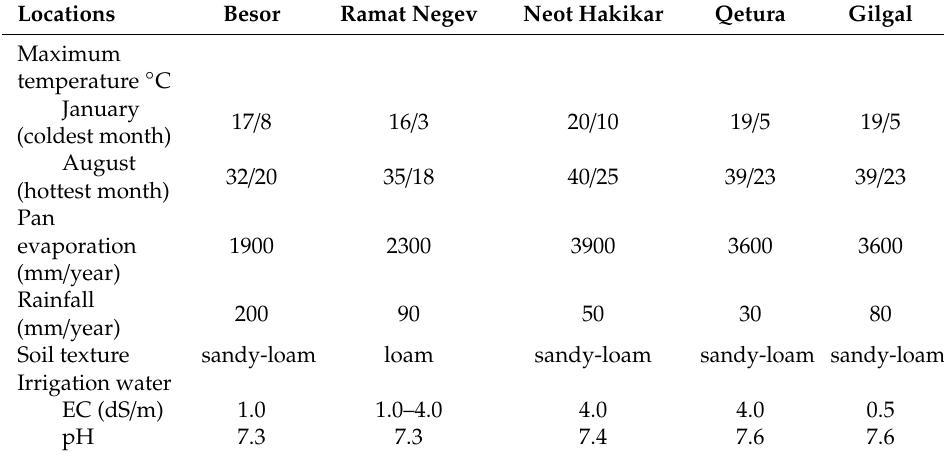
Table 1. Environmental and other characteristics (average values) of the introduction sites in the Israeli